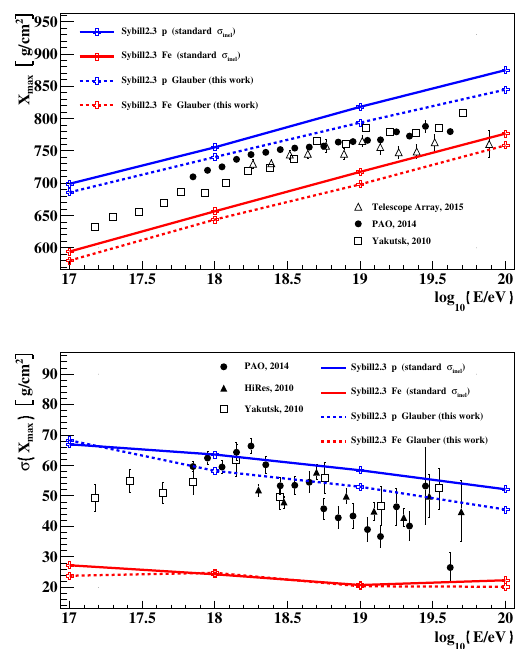
Figure 5. (top): Position of X max simulated using Sibyll 2.3c model with di ff erent σ inel . Results for our Glauber calculations (dotted line) are compared with original σ inel in Sibyll 2.3c model (solid line), (bottom): σ parameter of obtained X max